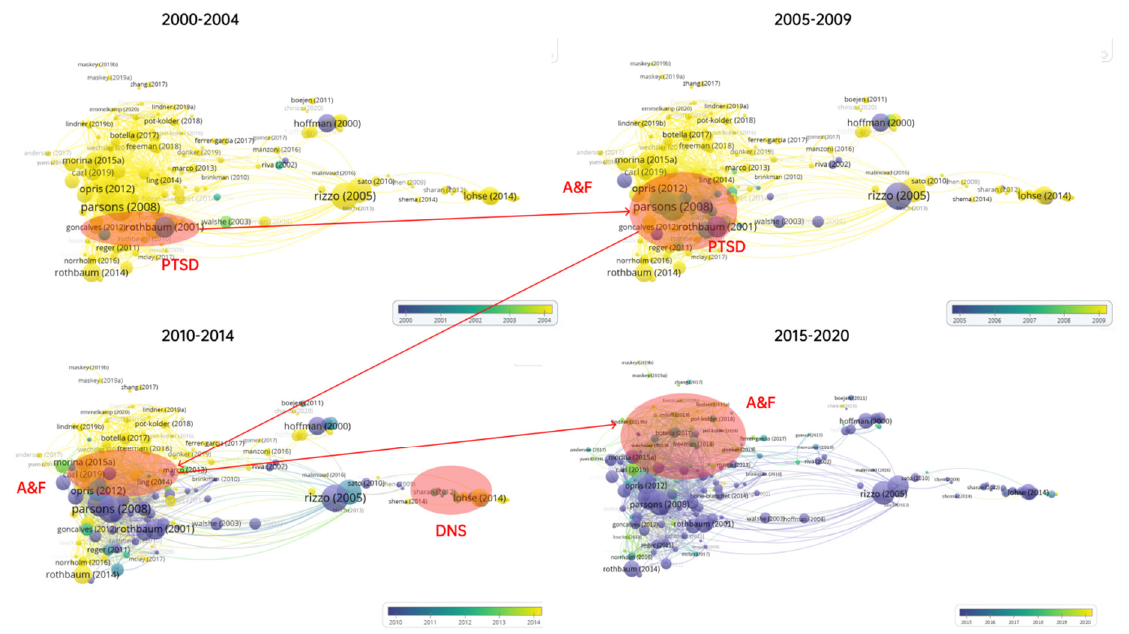
Figure 5. Four ranges in two decades (2000 to year 2020) of overlay visualizations of bibliographic coupling analysis of the theme of VR and therapy in the WoSc via VOSviewer (devised and generated by the authors).